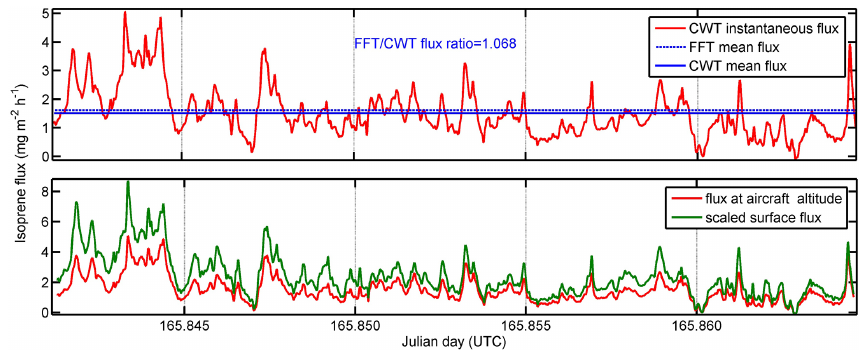
Figure 4. Isoprene flux processing. Upper panel: determination of the FFT/CWT flux ratio; lower panel: application of flux divergence coefficients (derived in racetrack profiles) to scale fluxes from aircraft altitude to surface fluxes using aircraft altitude and PBL